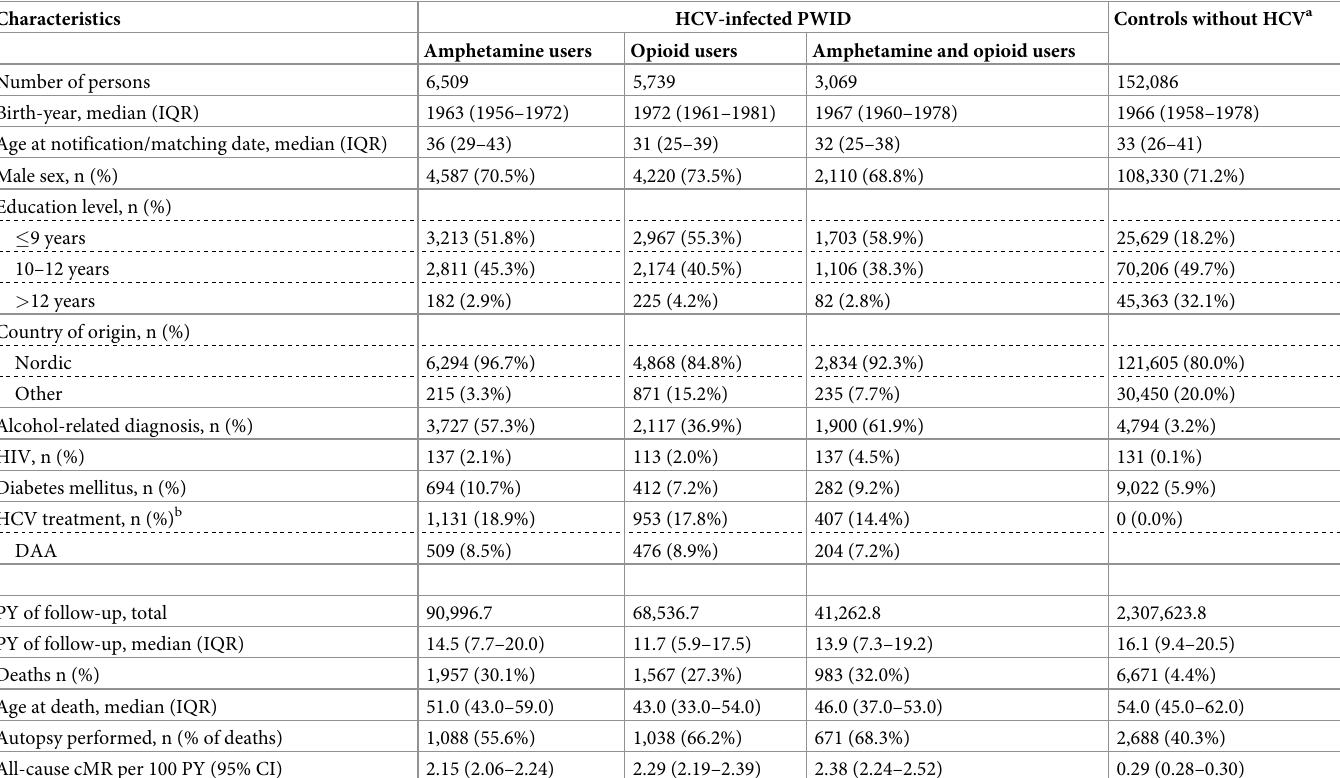
Table 1. a. Characteristics of study population by hepatitis C status and substance use (n = 15317). b. Observation time, age at death, and crude all-cause mortality rate by hepatitis C status and substance use.